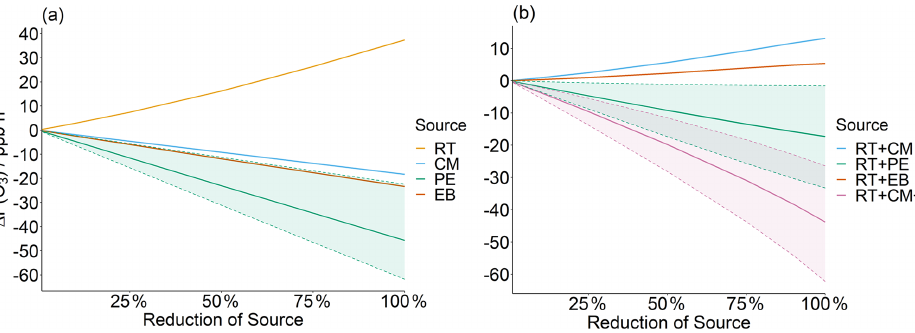
Figure 12. Change in P( O 3 ) on reducing RT, CM, PE, and EB (a) ; and (b) reducing road transport simultaneously along with either (i) CM, (ii) PE, (iii) EB, (iii) CM, or PE. The shaded region, bounded by a dashed line, represents the variability in (cid:49)P( O 3 ) when 0%–100% of observed monoterpenes contribute to anthropogenic EDGAR source sectors that include PE. The solid lines represent the base case whereby 50% of monoterpenes are assumed to be from anthropogenic sources described in the EDGAR inventory (the other 50% are assumed to be from biogenic